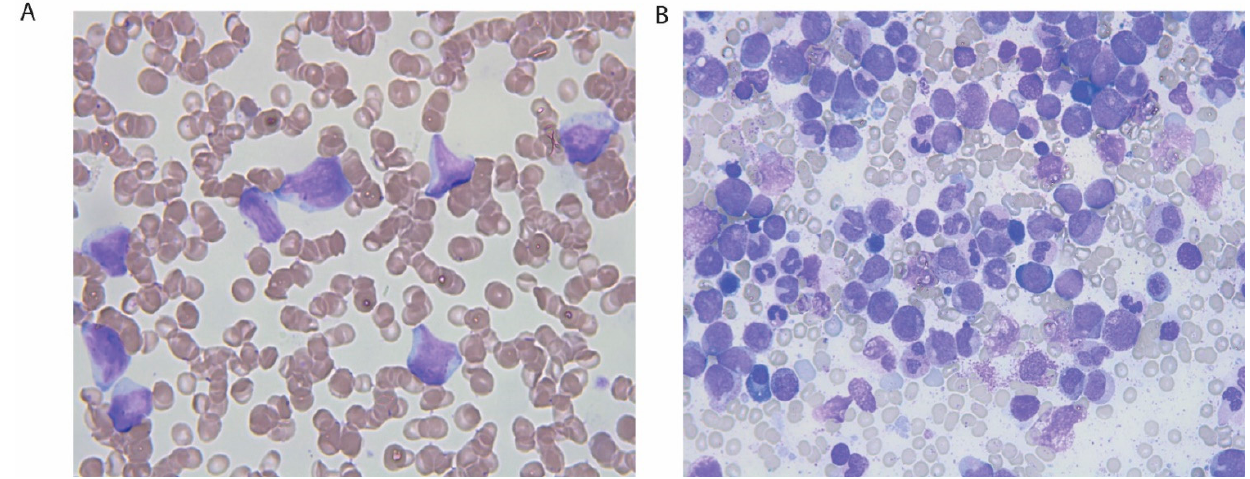
Figure 2. Blood and bone marrow smear, hematoxylin and eosin-stained sections. ( A ) Blood smear showing leukocytosis with a left shift, myelomonocytic blasts, and some more immature blasts. ( B ) Marrow aspirate demonstrating hypercellular marrow with dysplastic maturation of the myeloid and erythroid cell lines, myelomonocytic blasts, and myeloblasts.